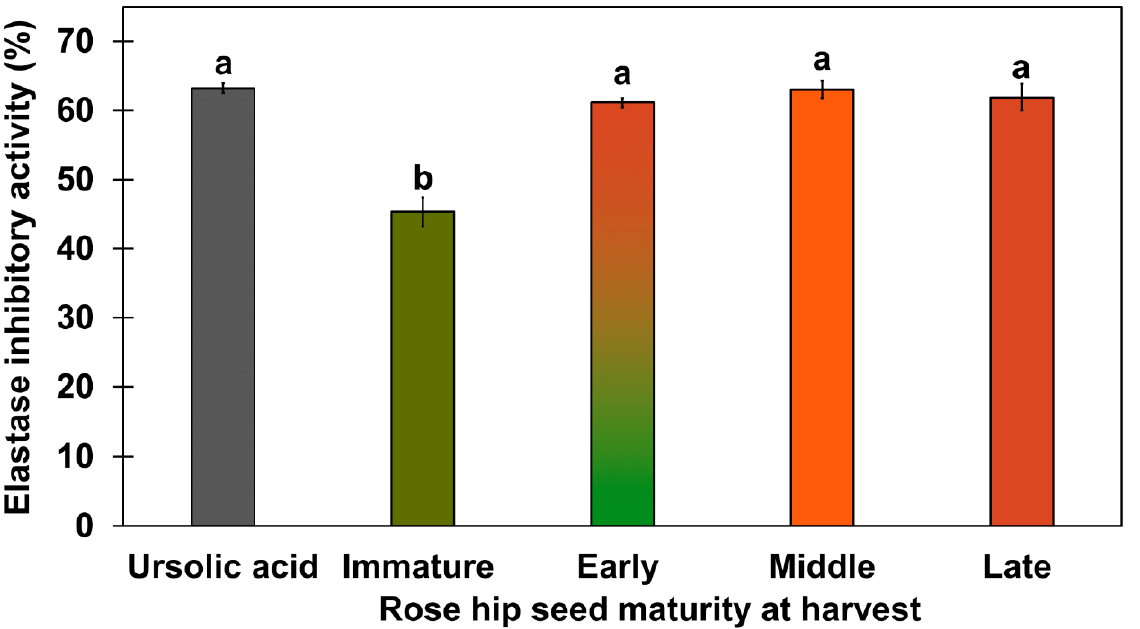
Figure 4. Elastase inhibitory activity of rose hip seeds from various ripening stages using 95% ethanol extract. Concentrations of freeze-dried rose hip seed samples were 400 µ g/mL. The concentration of ursolic acid used for positive control was 50 µ g/mL. Different letters above the error bars indicate significant differences according to Tukey’s HSD test ( p < 0.05).